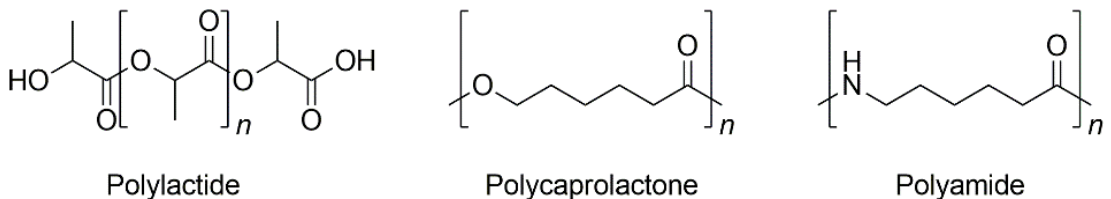
Figure 1. Chemical structure of the well-established polymer types for biomedical application used in this study.